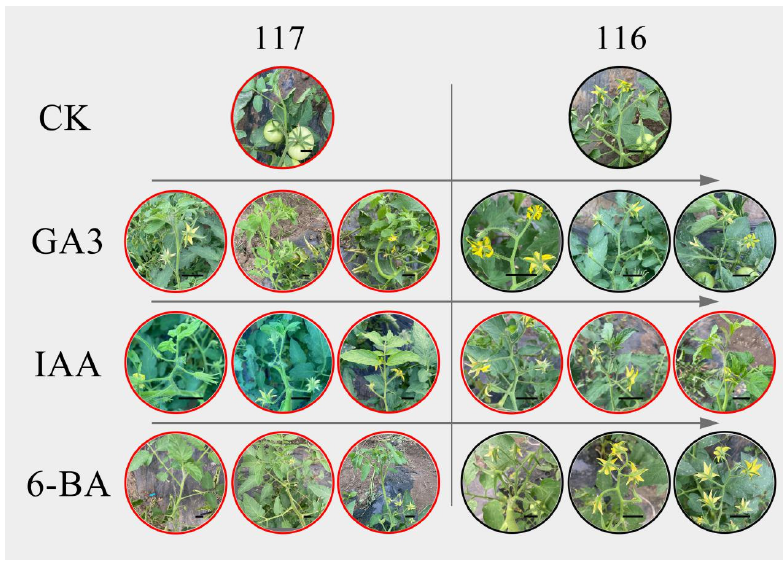
Figure 12. Plant phenotypes after hormone treatment. The red circles indicate the development of flowering reversion; the arrows indicate the gradual concentration increases. The black solid lines represent a scale of 2 cm.